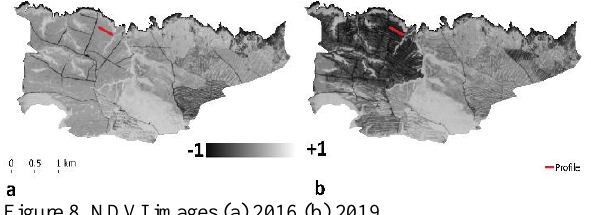
Figure 8. NDVI images (a) 2016 (b) 2019. Spectral profiles for the marked profile were derived from